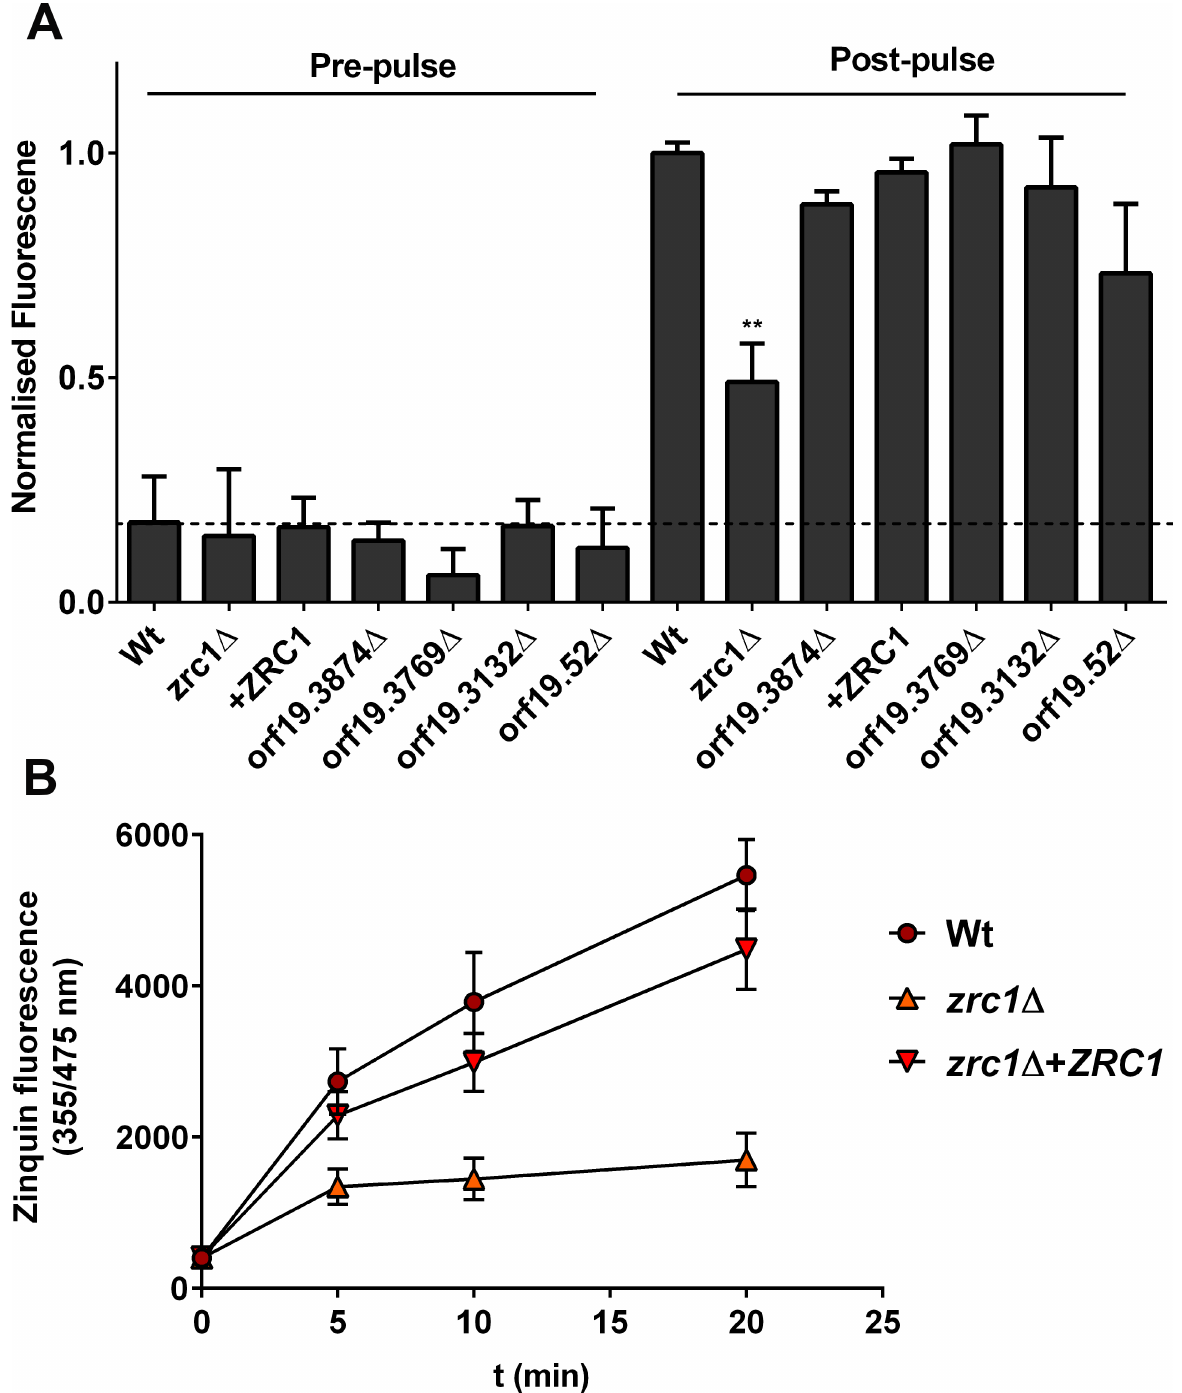
Fig 8. Zincosome formation is Zrc1 dependent. (A) Zincosome screen. Wild type, ZnT deletion mutants and zrc1 Δ + ZRC1 strains were pulsed with 25 μM zinc for 20 minutes and zincosome fluorescence determined by staining with zinquin. Prepulsed cells were also stained as control. Experiment was performed at least twice in duplicates and all data normalised to the post-pulse value of wild type. ANOVA was first performed on initial (pre-normalised data). Asterisks indicate statistical significance compared to wild type and to relevant deletion mutant (cid:3)(cid:3) P < 0.01. (B) As panel A, except zinquin fluorescence kinetics was determined by flow cytometry. Experiment performed three times. zrc1 Δ exhibits significantly reduced zinquin fluorescence compared to wild type and revertant at 20 minutes P < 0.001, ANOVA.